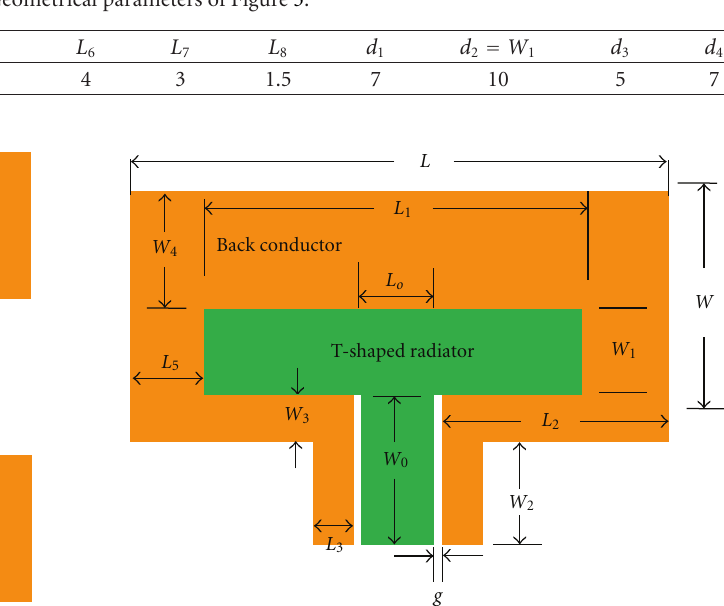
Figure 2: Geometry of the proposed antenna without slots at the ground plane.